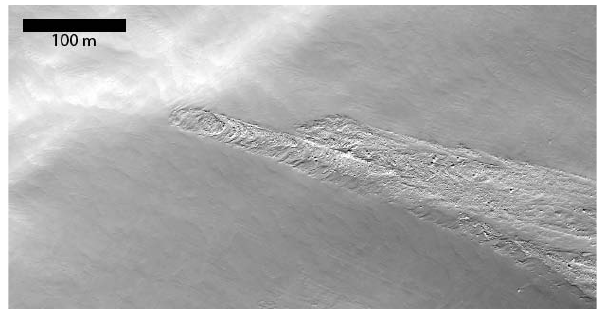
Fig. 3. Part of a single snow avalanche deposit in the Davos region of Switzerland. Image acquired with a Leica ADS40-SH52 opto- electronic pushbroom scanner. (Flow direction is from the lower right to the centre of the